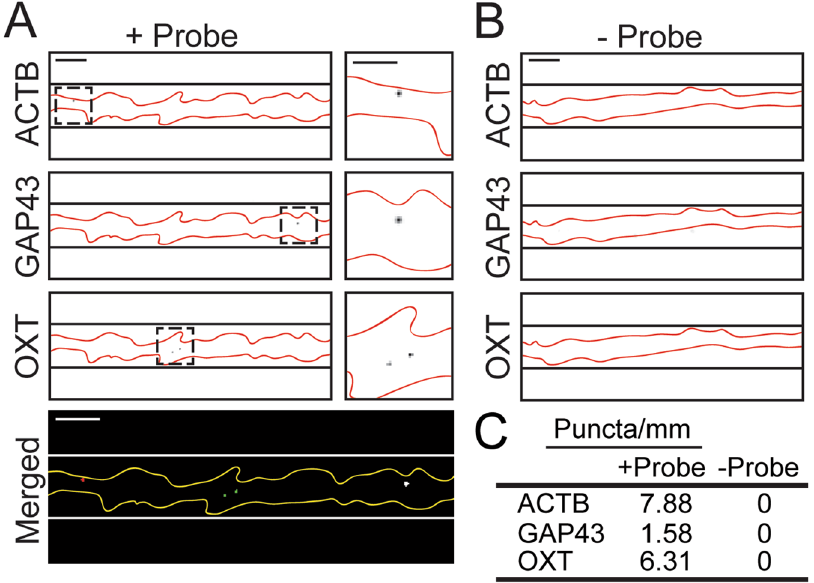
Figure 4. Mulitplexed RNA-FISH verification of mRNA within the distal projections of hESC-neurons. ( A ) Representative image of hESC-neuron projections processed for RNA-FISH with gene specific probes for β -actin (ACTB, red), Growth Associated Protein 43 (GAP43, green) and Oxytocin (OXT, white). Individual greyscale images (inverted fluorescence) for each probe and a merged color image are shown. In the greyscale images black lines delineate the microgroove walls and the neuronal projection is outlined in red. The region within the dashed box is enlarged to the right of each image, scale bar is 5 µ m. In the merged image white lines delineate the microgroove walls and the neuronal projection is outlined in yellow, scale bars are 10 µ m. ( B ) Representative portion of a negative control hESC-neuron axon processed for RNA-FISH without gene specific probes. Individual greyscale images for each probe are shown. Scale bars 10 µ m. ( C ) Quantification of RNA- FISH puncta per unit